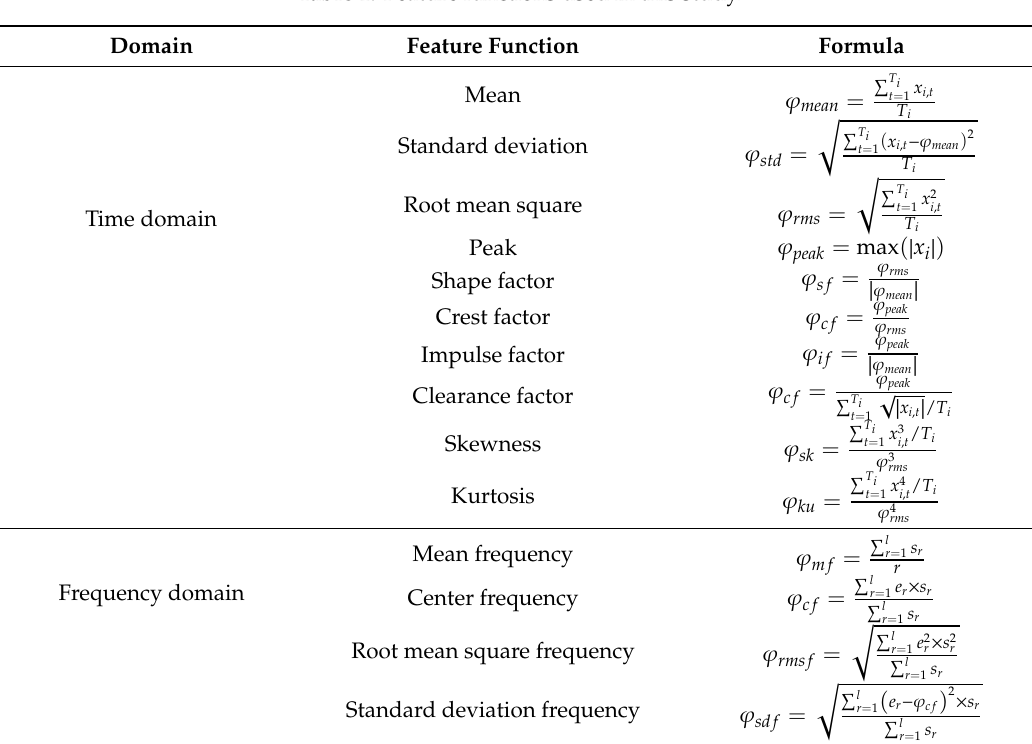
Figure 1. Development process of feature-based time series classifier. Table 1. Feature functions used in this